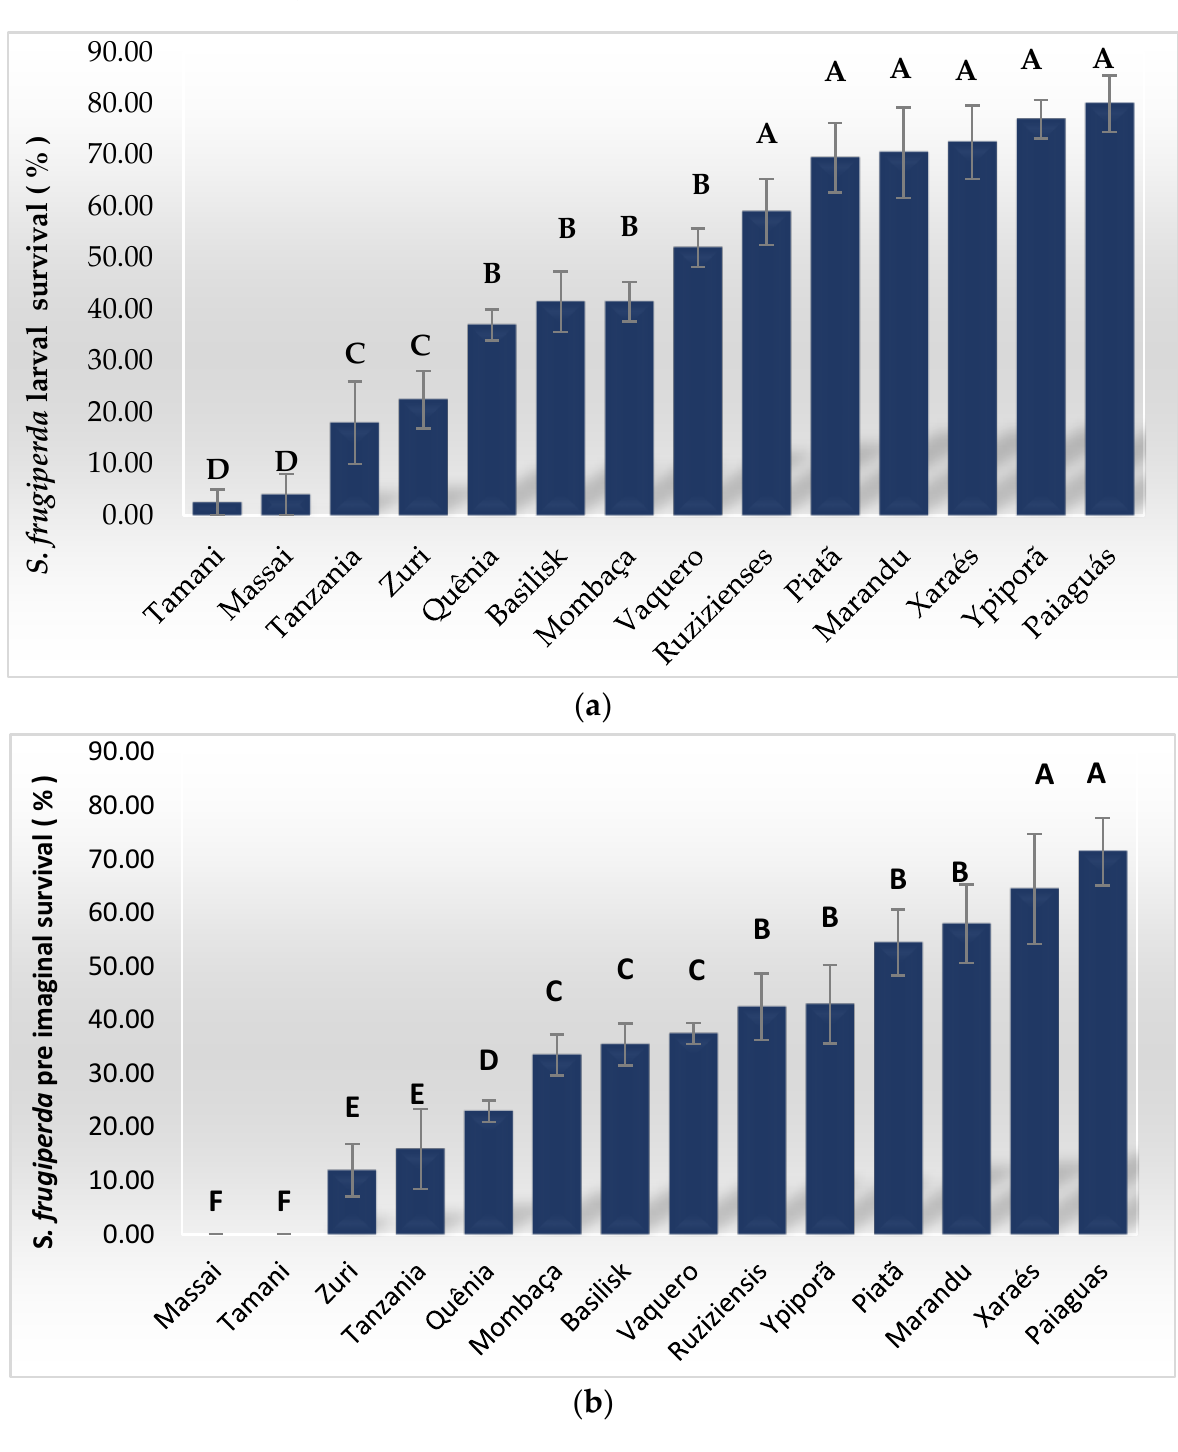
Figure 1. Larval survival ( a ) and pre-imaginal survival ( b ) of Spodoptera frugiperda on different forage and cover crops. Means followed by the same letter do not differ from each other by the Scott – Knott test ( p > 0.05).